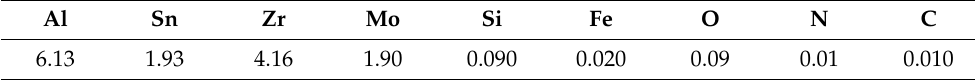
Table 1. The normal chemical composition of Ti6242s alloy (wt, %).